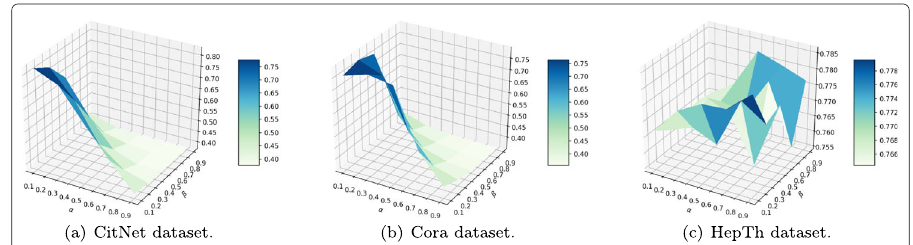
Fig. 6 Macro- F 1 scores on the three datasets in hyper-parameter sensitivity evaluation